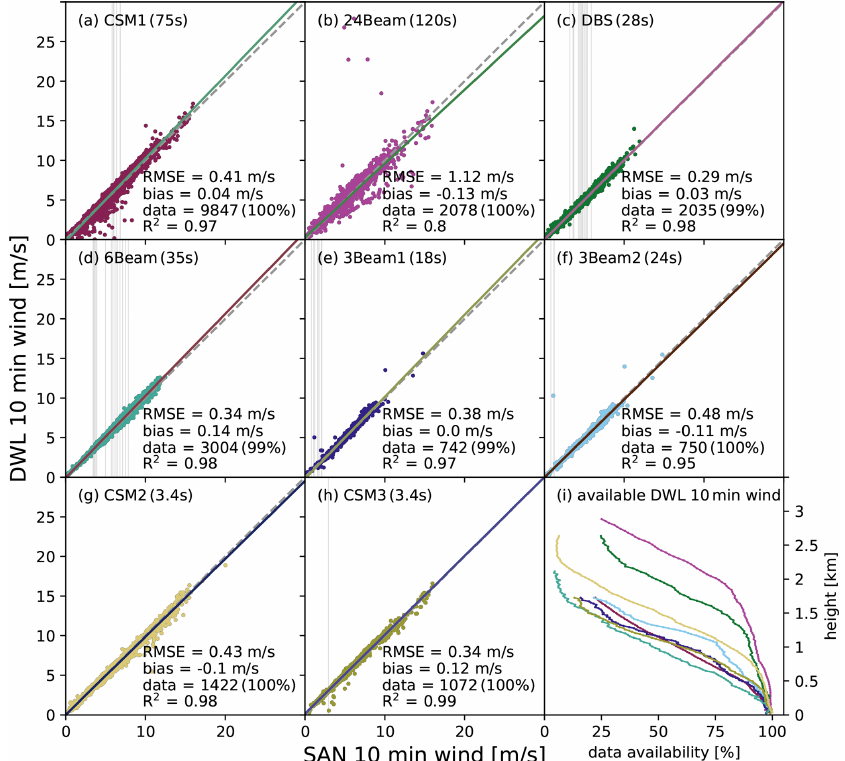
Figure 7. Scatterplots of 10min mean horizontal wind from the sonic anemometer (SAN) versus DWL for the eight different tested DWL configurations at 90.3m. Colors and letters (a) – (h) correspond to the configurations shown in Fig. 3 with the measurement configuration schedule given in Table 1. For each panel, the colored linear fit line, the root mean squared error (RSME), the bias, the involved data, and the coefficient of determination ( R 2 ) are given. The parameter data indicate in parentheses the fraction of situations in which the DWL retrieval returned valid wind values. Grey vertical lines indicate sonic anemometer measurements with missing corresponding DWL results. Panel (i) shows the DWL data availability against height with colors per configuration as in panels (a) – (h)